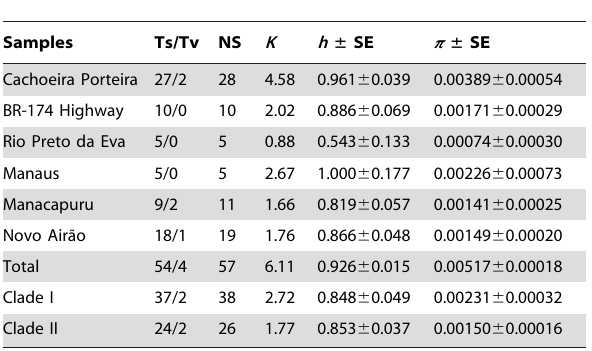
Table 3. Intra-population genetic diversity measures for each sample, combined data and haplotype clade of Lutzomyia umbratilis .